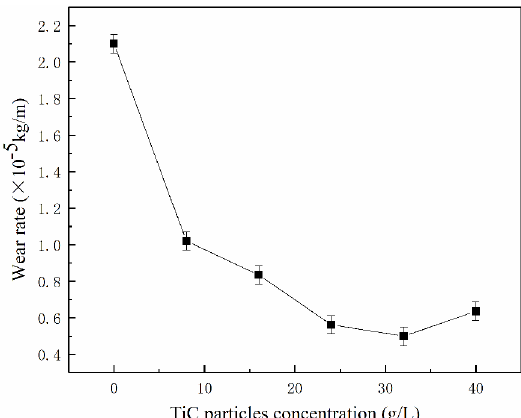
Figure 11. Effects of TiC concentration on the wear rate of Ni-TiC composite coatings